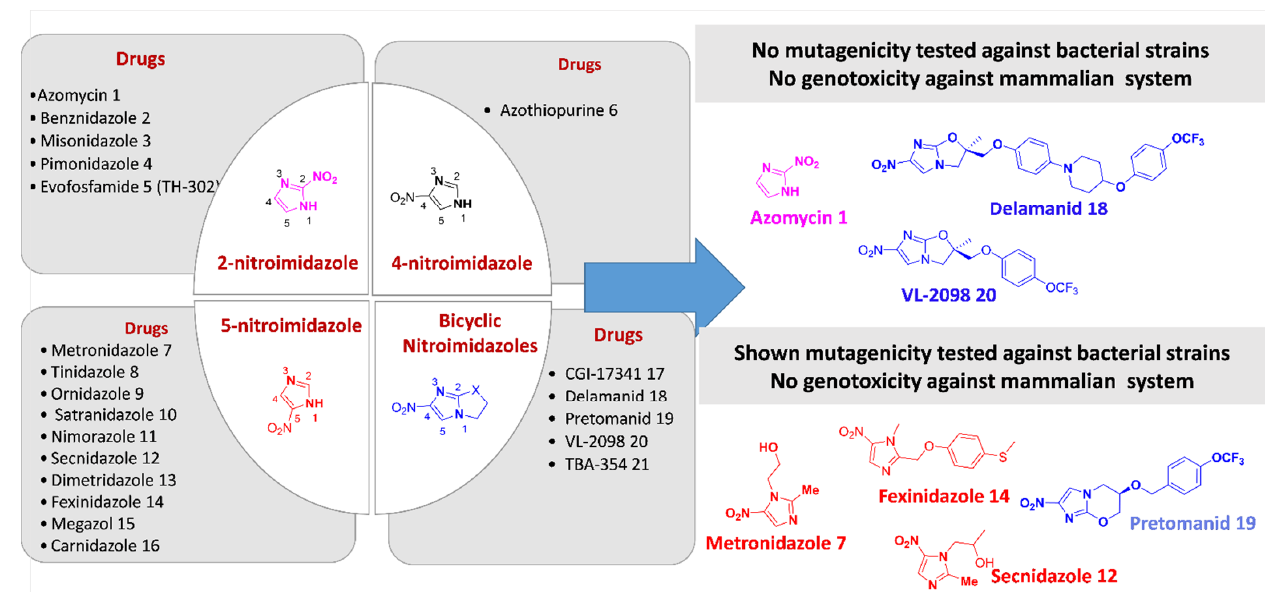
Figure 33. Summarized mutagenic trend in nitroimidazole scaffold.